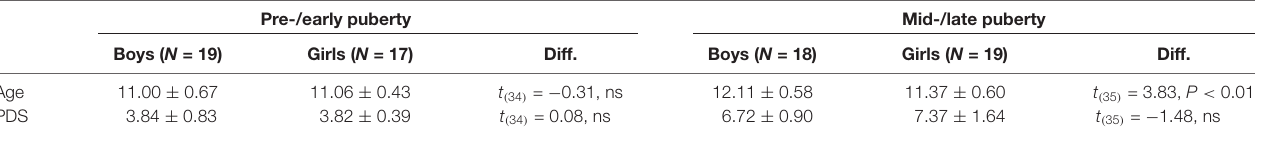
TABLE 1 | The means and standard deviations of ages and the pubertal development scale (PDS) scores for each